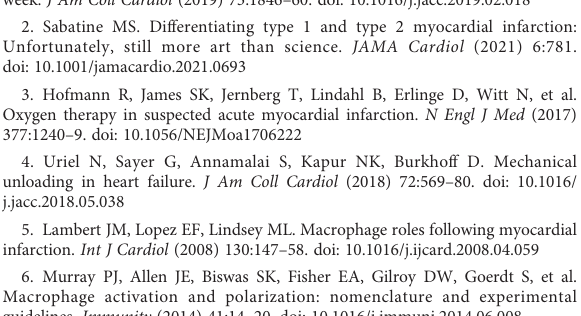
SUPPLEMENTARY FIGURE 1 Differentially expressed of TRIMs family in LPS-stimulated macrophages. Heatmap shows the log10 (normalized counts +0.01) of TRIMs family from (A) GSE147310 and (B) GSE158889 microarray. Top 25 differentially expressed genes (DEG) in (C) GSE147310 and (D) GSE158889 microarray. Red represents high expression, blue means low expression. SUPPLEMENTARY FIGURE 2 Establishment andveri fi cationofTRIM21 knockoutinmice. (A) Diagramof the partial TRIM21 gene body showing the TALEN (Transcription Activator-Like Effector Nuclease) target sites (top), and DNA sequences of the cloned polymerase chain reaction products in WT, TRIM21 -/- and TRIM21 heterozygous (TRM21 +/- ) mice (bottom). (B) Agarose gel images of digestion products from WT and TRIM21KO mouse tail digested with a T7E1assay. (C) WesternblotassayshowstheleveloftheTRIM21proteinin the WT and TRIM21 -/- hearts. Data are representative of 3 independent experiments. n = 2